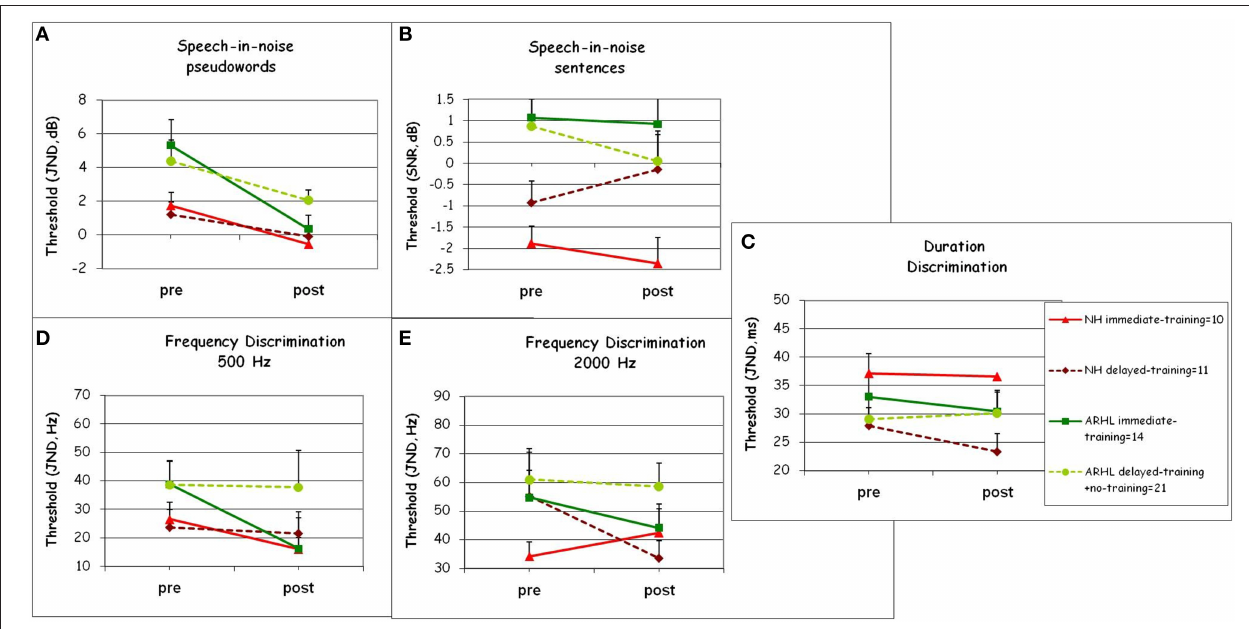
Frontiers in Psychology |